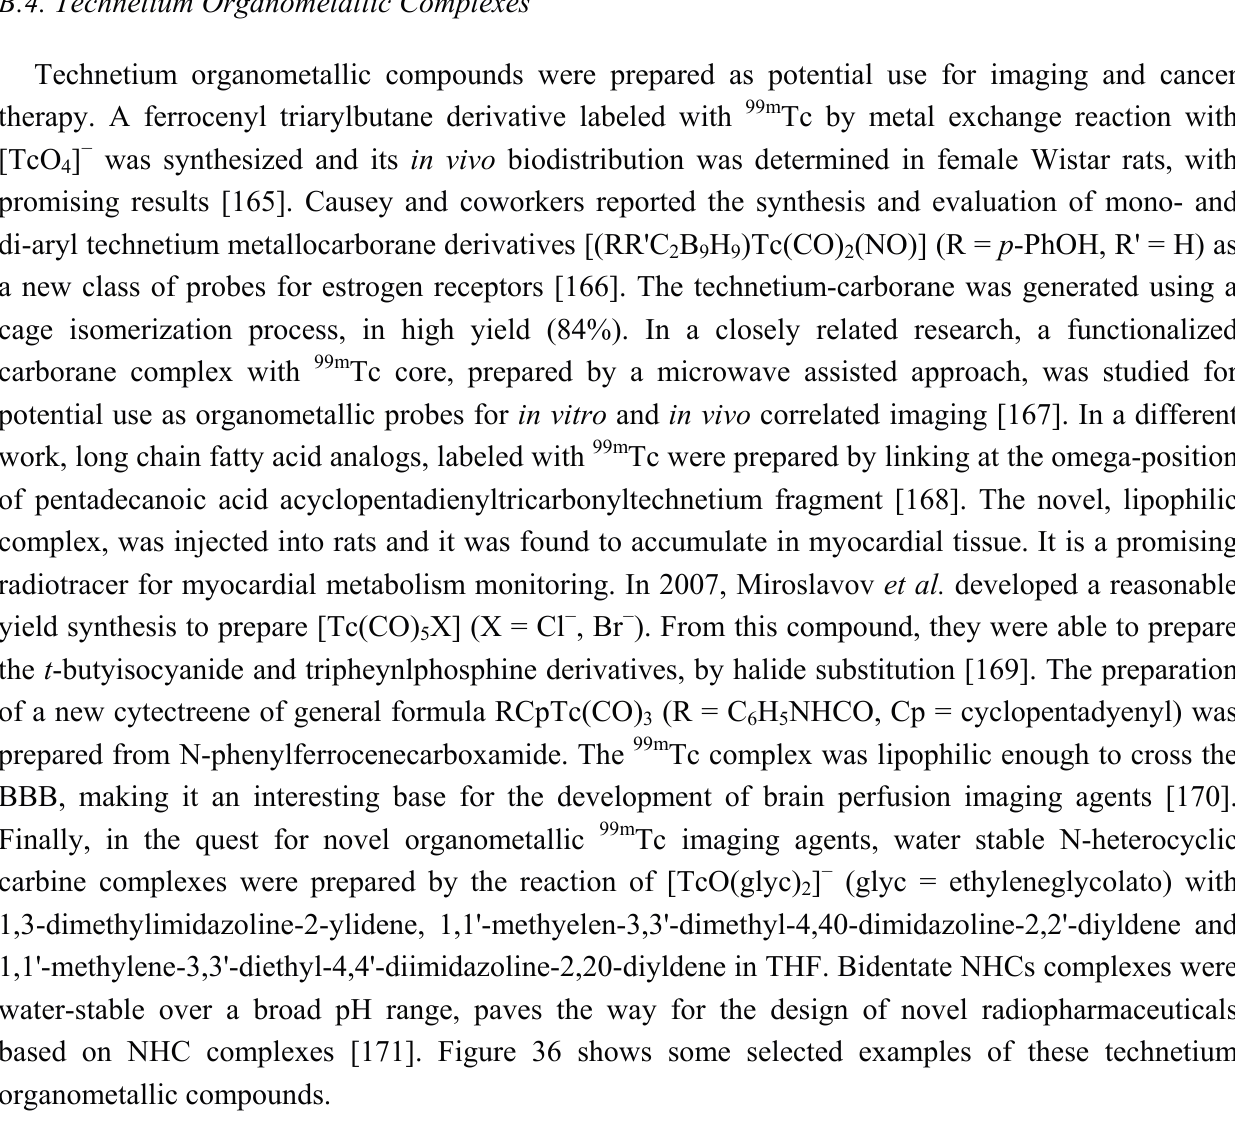
Figure 36. Selected technetium organometallic